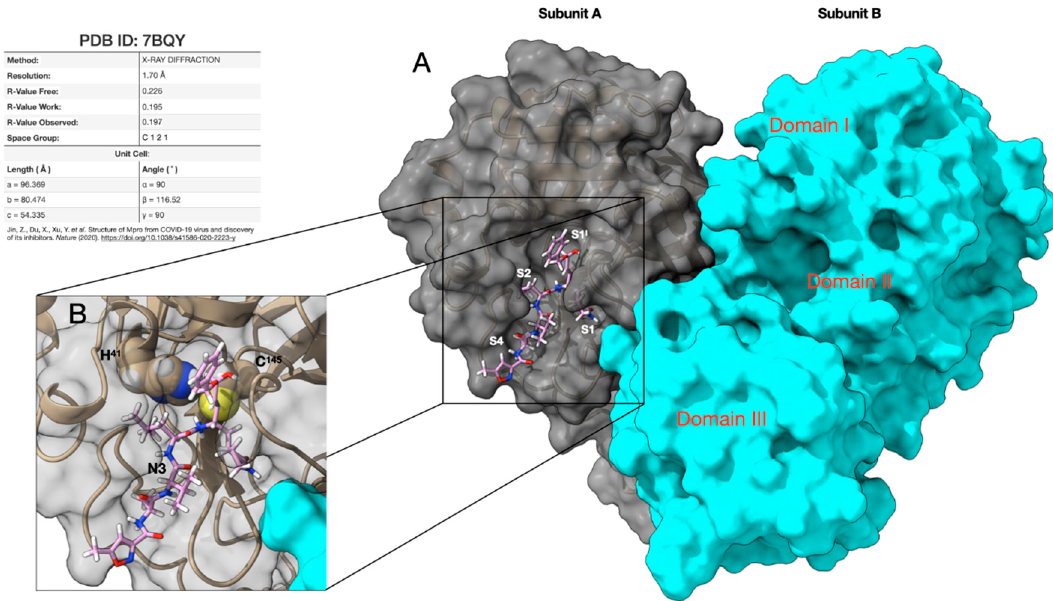
Figure 1. Structure of the SARS-CoV-2 M pro used in this work (subunit A) as a target for virtual screening and molecular docking. ( A ) 3D representation of the SARS-CoV-2 main protease dimer complexed with the inhibitor N3 showing the three domains (I–III) and the binding pockets S1 I , S1, S2, and S4. Subunits A (silver) and B (light blue) are drawn as solvent accessible surfaces (SAS) while N3 is rendered in a stick. ( B ) Particular of the catalytic dyad composed of the C 145 and H 41 residues rendered in CPK (Corey-Pauling-Koltun). The thiol group of C 145 , belonging to the S1 I pocket, anchors the N3 inhibitor by a covalent linkage, thus allowing it to maintain the activity. Protein data bank (PDB) accession code, data collection, sand refinement statistics of the structure are summarized in Table S1.